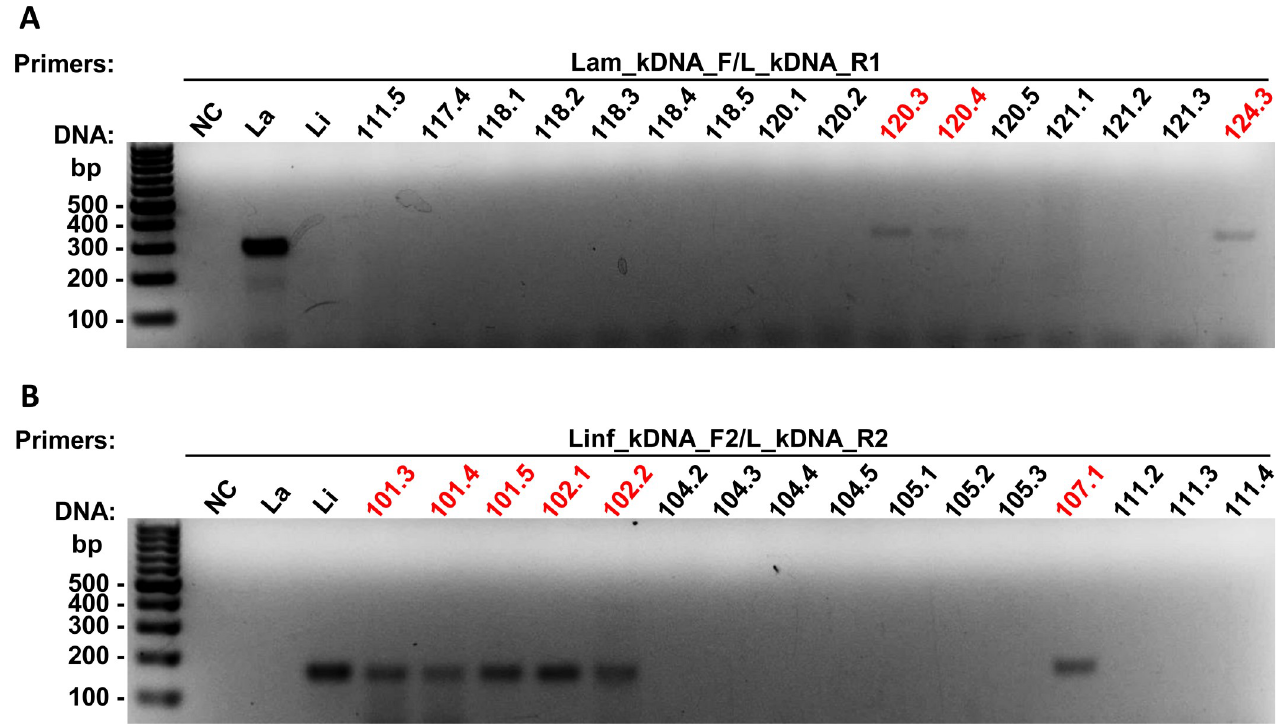
Fig 4. PCR analysis of Lu . longipalpis gDNA, using primers derived from L . amazonensis and L . infantum kDNA. Representative gels of the PCR with individual DNA samples of sand flies, using the primers Lam_kDNA_F/L_kDNA_R1, which amplify L . amazonensis with a fragment of 294 bp (A) , and Linf_kDNA_F2/L_kDNA_R2, which amplify L . infantum with a fragment of 183 bp (B) . Samples marked in red were positive for the respective primers tested. bp: molecular size marker in base pairs; NC: negative control (without DNA); SFN: not infected sand fly; DNA control: La: L . amazonensis ; Li: L . infantum .